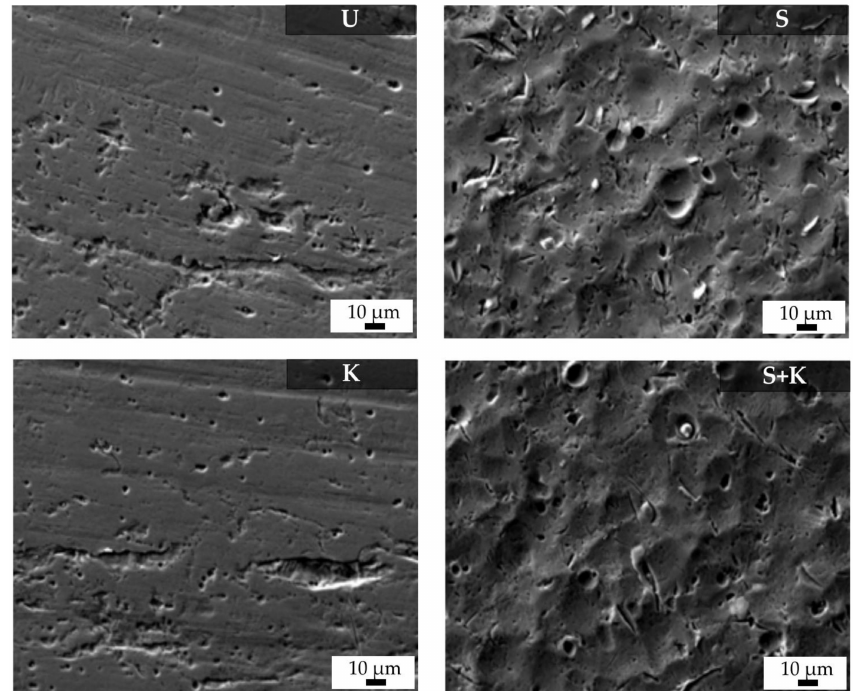
Figure 7. SEM micrographs of the stainless steel surfaces treated by di ff erent cleaning procedures. The applied cleaning procedure is indicated by the abbreviation in the upper right corner of each figure (U – ultrasonic cleaning, K – chemical etching with Kroll’s reagent, S – sandblasting, S + K – sandblasting + chemical etching with Kroll’s